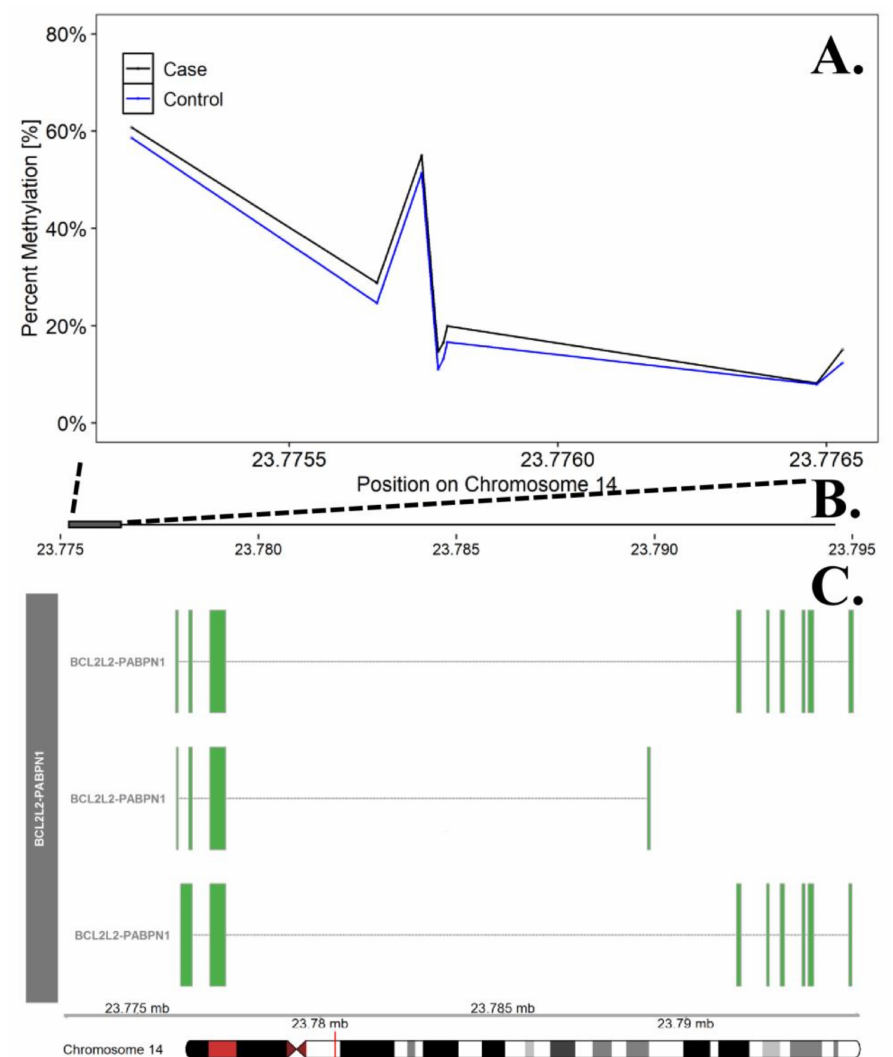
Figure 2. Differentially Methylated Region in the BCL2L2-PABN1 Promoter Region on Chromosome 14. The top panel ( A ) describes differences in percent methylation between cases and controls at each probe included in the promoter region for BCL2L2-PABN1 . This region was the most significant DMR in the discordant twin analysis. The X axis represents the position (mb) of the probes. The middle panel ( B ) represents the location of promoter region (solid square) relative to the entire gene, represented in the bottom panel. Multiple known isoforms of BCL2L2-PABN1 are represented in the bottom panel ( C ), boxes represent exons and lines represent introns. The red line on the ideogram, bottom of the figure, represents location of the region within the